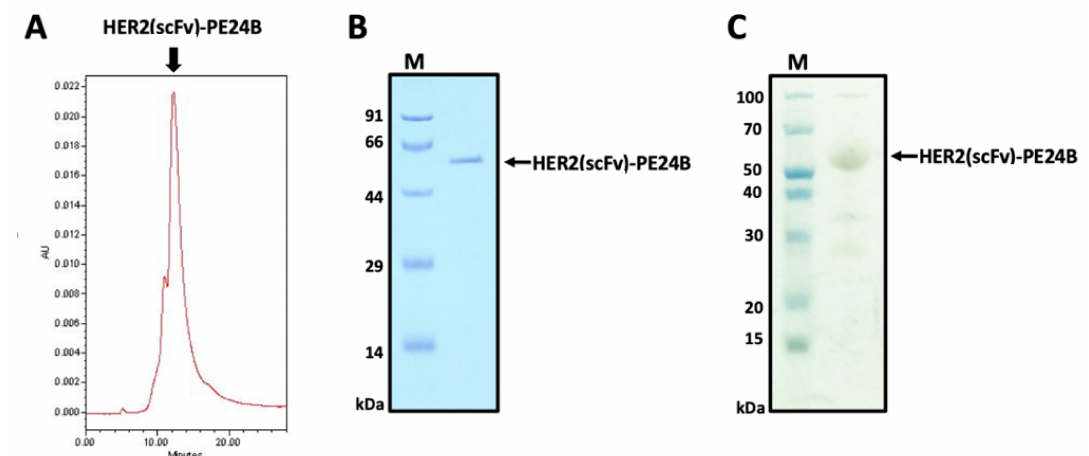
Figure 4. Determination of the purity of HER2(scFv)-PE24B. ( A ) Purified HER2(scFv)-PE24B was analyzed by HPLC using a Protein-pak 300SW SEC column to evaluate the purity. The x -axis shows the retention time (min) and the y -axis indicates the absorbance at 280 nm (arbitrary units, AU). The main peak of HER2(scFv)-PE24B is visible at 12.239 min. ( B ) Fractions from ( A ) were analyzed using SDS-PAGE. ( C ) Silver staining of the SDS-PAGE gel to assess the purity of the recombinant immunotoxin HER2(scFv)-PE24B (53.5 kDa).